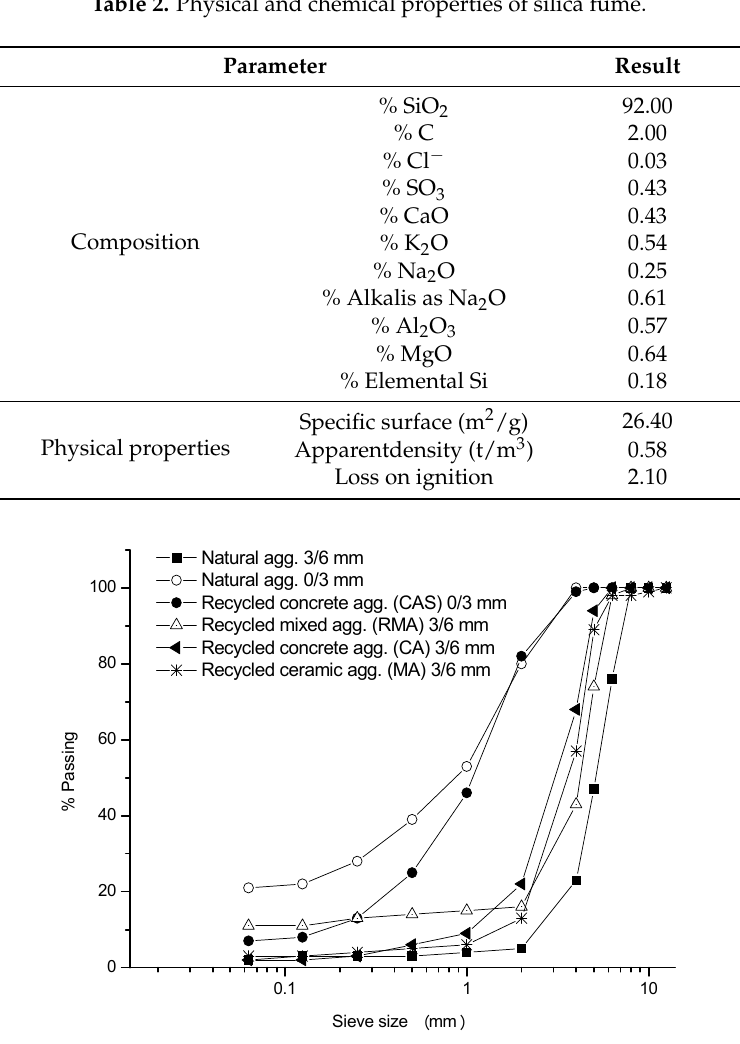
Figure 1. Grading curves of recycled and natural aggregates. Table 3. Properties of natural aggregate.